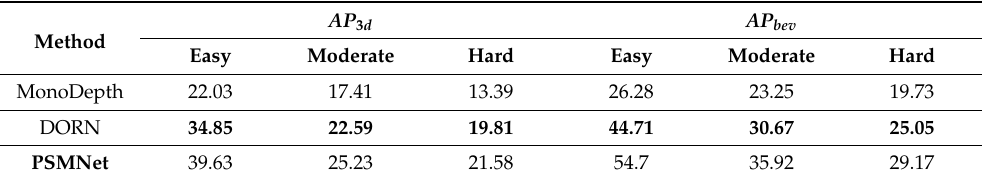
Table 3. Performance difference of three depth estimators.